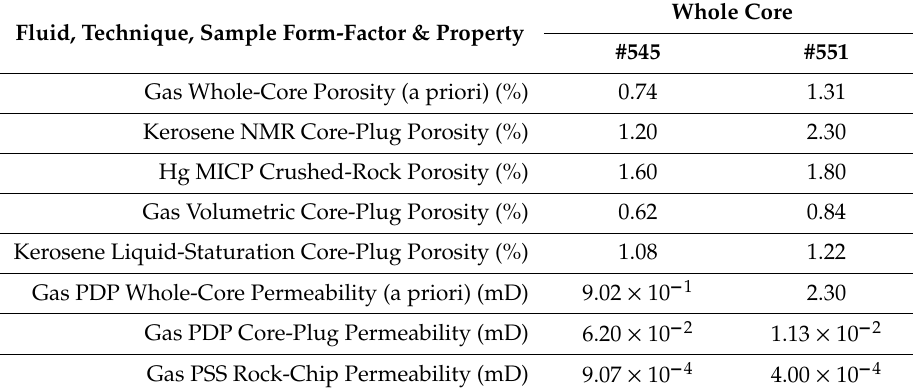
Table 3. Porosity and permeability of the whole core